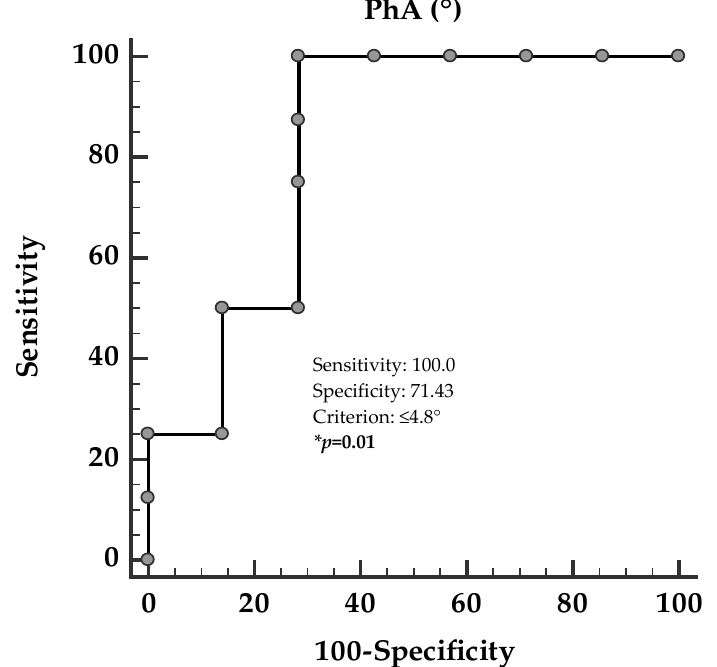
Figure 3. The correlation between PhA and hs-CRP levels, after adjustment for gender, BMI, and waist circumference in PWS adults. PhA showed also a negative association with hs-CRP levels (r = − 0.71, p = 0.003), and as shown in the figure, this negative association remained also after adjustment for covariates ( p = 0.01). PhA, phase angle; hs-CRP, high-sensitivity C-reactive protein. * A p- value < 0.05 means a significant di ff erence.